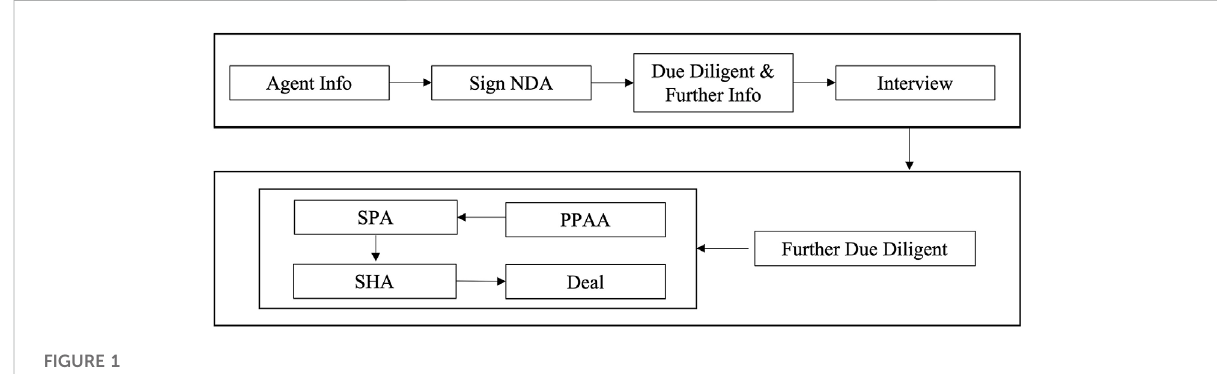
FIGURE 1 Work fl ow of primary